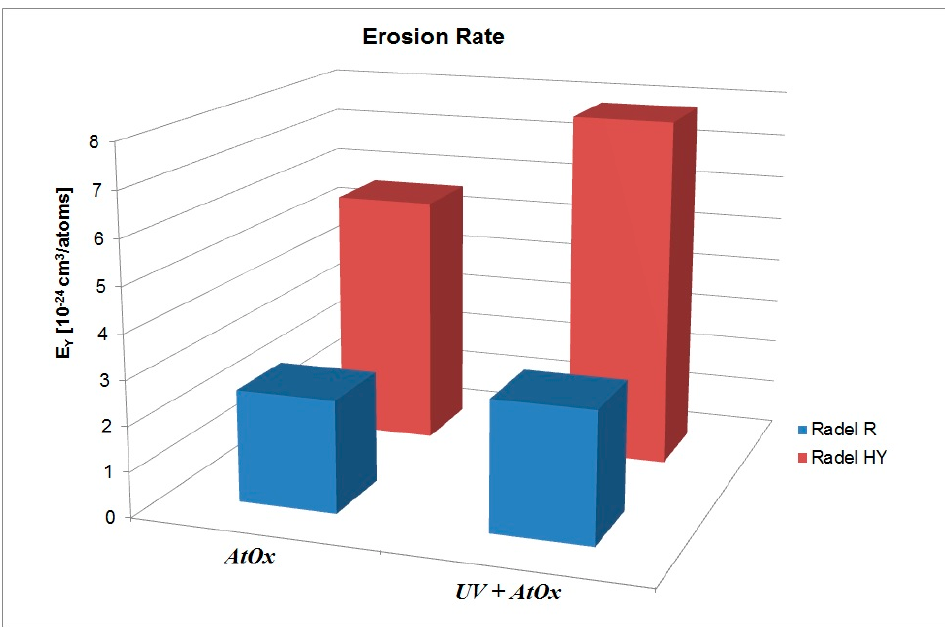
Figure 5. UV/AtOx aging characterization: erosion rate estimated from the measured mass loss.